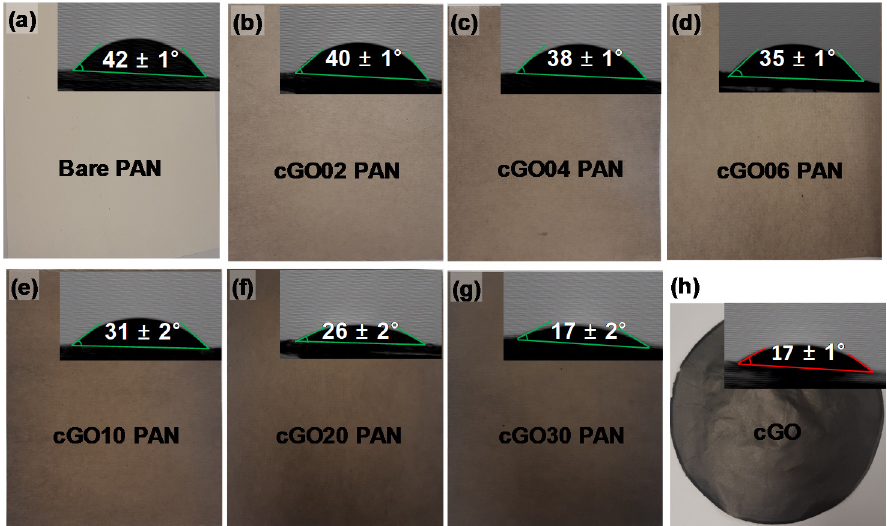
Figure 3. Digital photo and water contact angle of ( a ) bare PAN, ( b – g ) composite nanofiber membranes as a function of the cGO content, and ( h ) CTAC-modified GO (cGO).